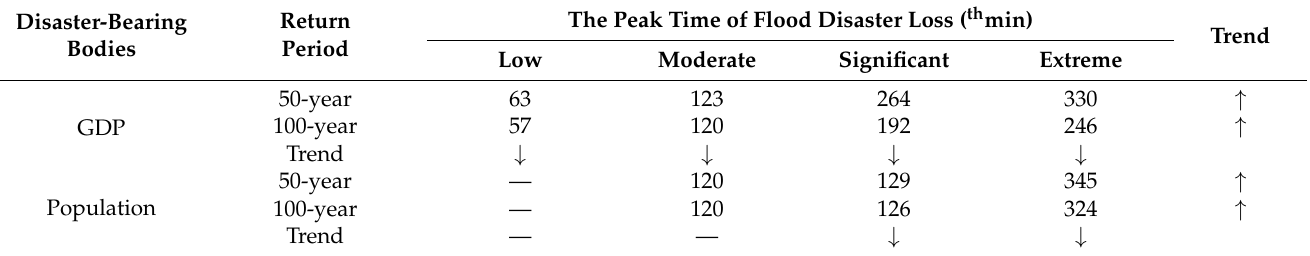
— represents no data or no trend, ↑ represents an increasing trend, ↓ represents a decreasing